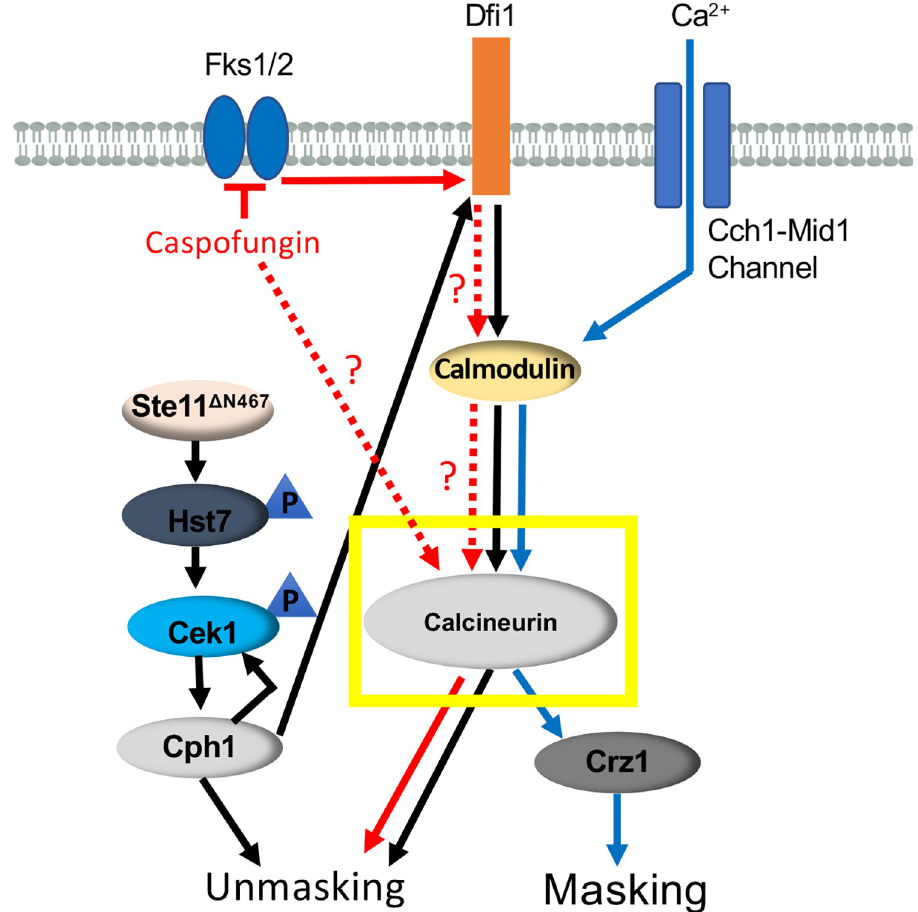
Fig 3. Proposed model for calcineurin-regulated ß(1,3)-glucan exposure. Our data suggest that calcineurin serves as a switchboard in mediating ß(1,3)-glucan exposure in response to different stimuli: hyperactive STE11 Δ N467 expression (black lines), caspofungin exposure (red lines), and high levels of exogenous calcium (blue lines). With regards to hyperactive STE11 Δ N467 expression, we propose that activation of the downstream transcription factor Cph1 leads to increased expression of the cell wall sensor Dfi1 as well as architectural cell wall changes that are then sensed by these same Dfi1 proteins. This sensor in turn interacts with calmodulin to initiate signal transduction down a Dfi1/ calmodulin/calcineurin signal transduction pathway and further increases ß(1,3)-glucan unmasking. In response to caspofungin exposure, calcineurin is also necessary to induce the full levels of unmasking observed in wild-type cells. Based on our data, calcineurin may act in a partially Dfi1 dependent manner, but an alternative regulator also mediates calcineurin activity in response to caspofungin treatment. Lastly, we propose that calcineurin is also capable of decreasing ß(1,3)-glucan exposure levels in response to growth in high levels of exogenous calcium, and is likely mediated via the canonical calmodulin/calcineurin/Crz1 signal transduction pathway. Dotted arrows indicate putative pathways that have not yet been experimentally